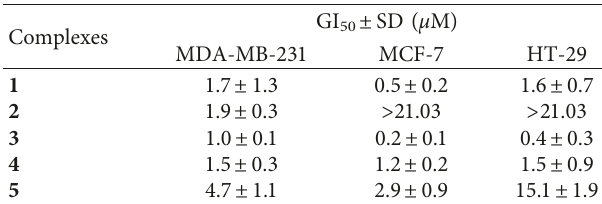
Table 3: GI 50 ( µ M) of different cancer cell lines after 48 h of ex- posure to